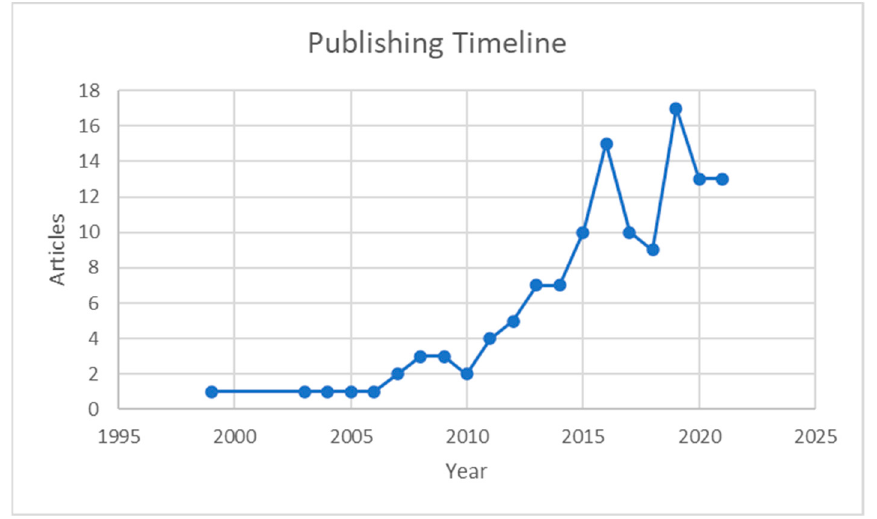
Figure 1. Number of articles per year.